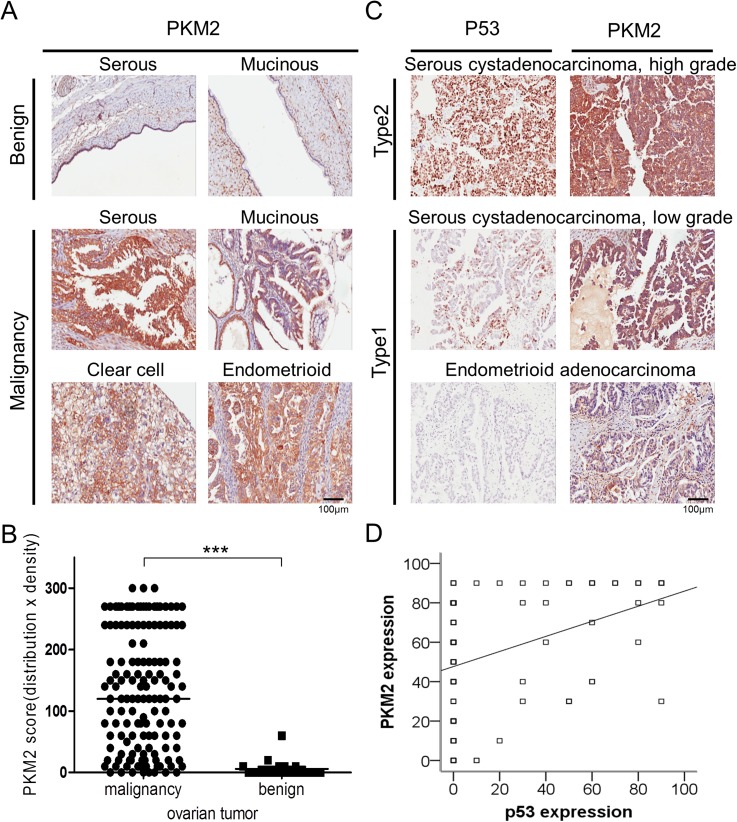
Expression and distribution of PKM2 in different histological types of epithelial ovarian tumor.(A) Proportion of PKM2 expression in cells of different histologic types of benign and malignant ovarian tumor. (B) Representative differential PKM2 expression in benign and malignant groups of epithelial ovarian tumor. *p < 0.001. (C) Proportion of p53 and PKM2 expression in cells of different histologic models of ovarian cancer. (D) Spearman's rho showed moderate correlations between PKM2 and p53 expression. PKM2, Pyruvate kinase M2.